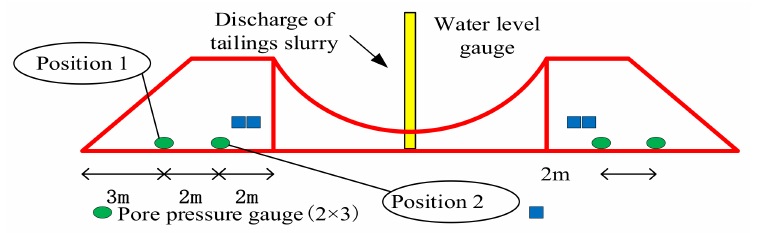
Figure 3. Layout of the field measuring instruments.